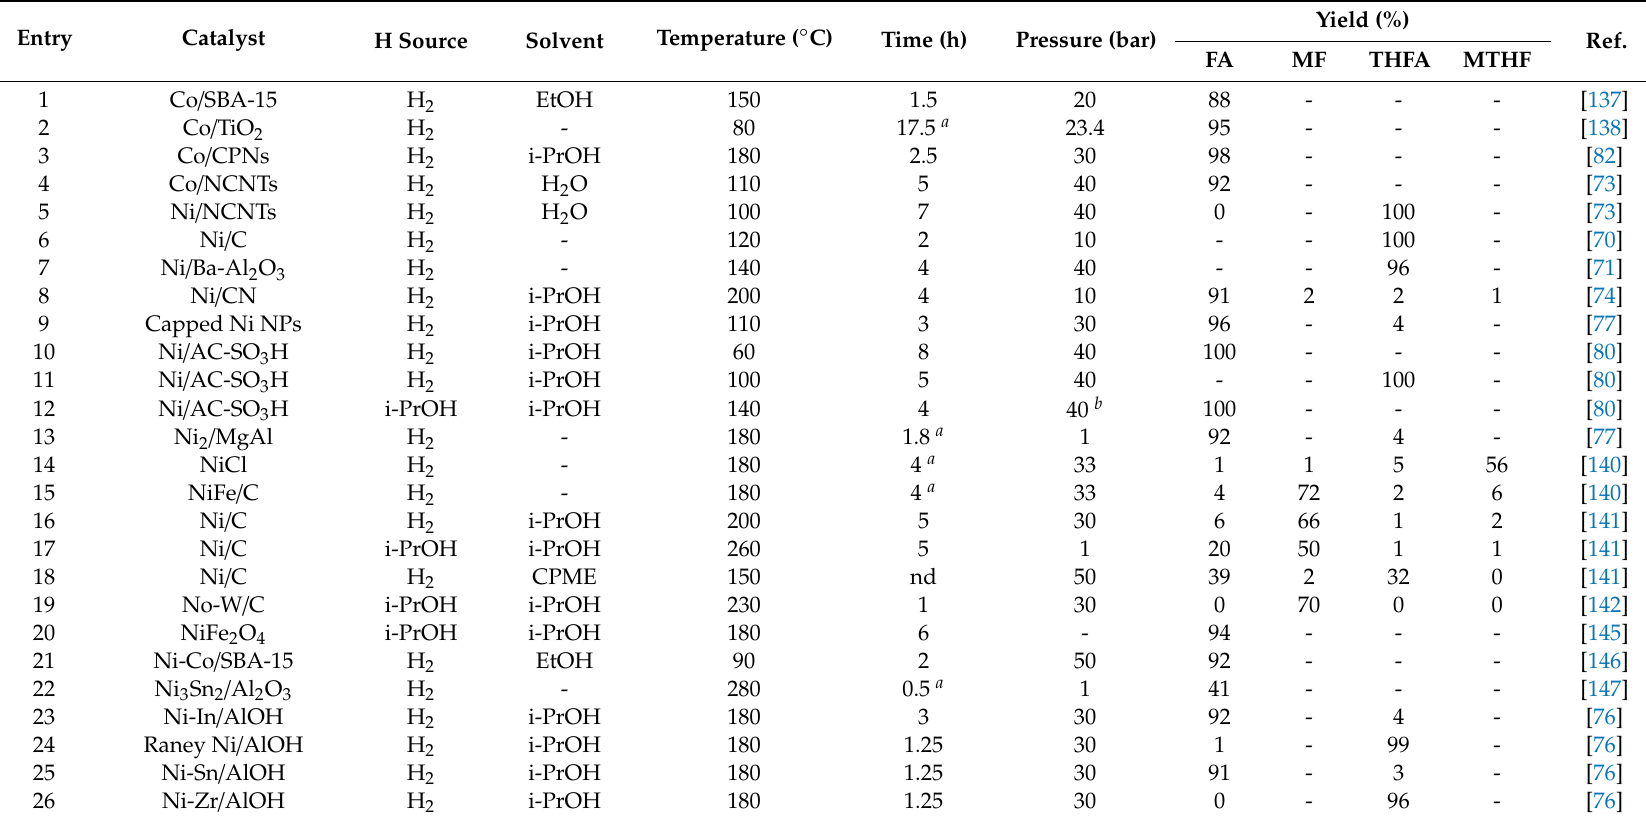
Table 2. Furfural hydrogenation over Co, Ni-based